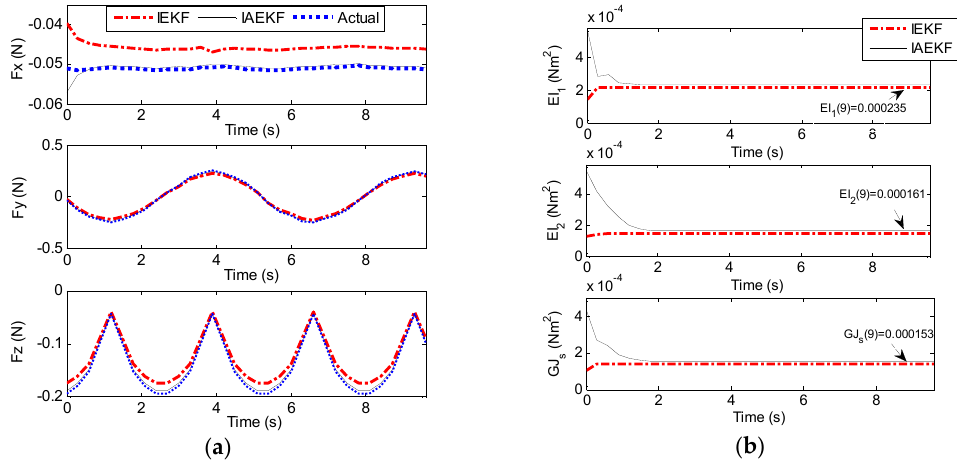
Figure 14. CFSE estimation with the applied tip contact forces using the setup in Experiment II (b): ( a ) Contact force estimation; ( b ) Stiffness estimation.